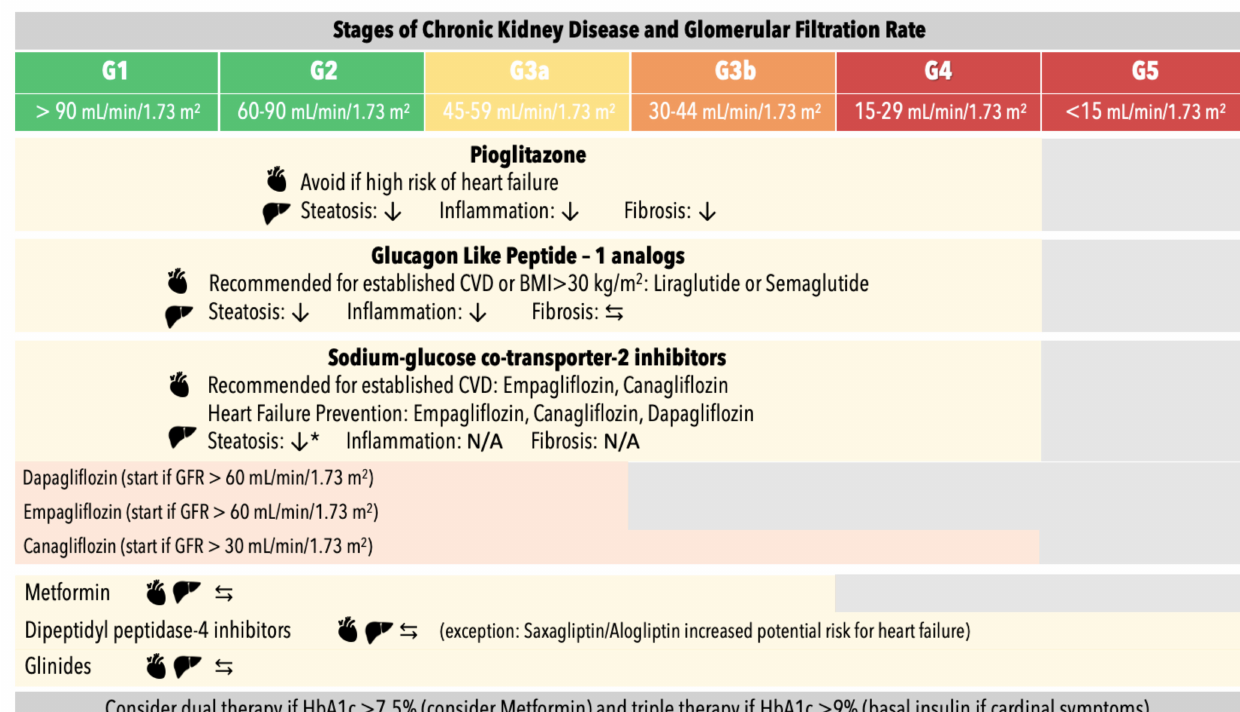
Figure 3. Antidiabetic drugs in patients with type 2 diabetes, chronic kidney disease and non-alcoholic fatty liver disease: description of histological liver effects and cardiovascular recommendation. ↓ : reduce; (cid:28) : neutral effect; N/A: no data available; * No histological evidence, GFR: glomerular filtration